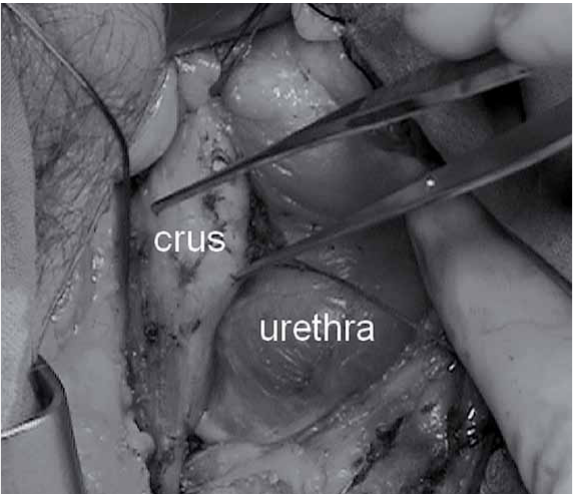
Figure 4 - After the perineal incision, we can see the urethra and penile